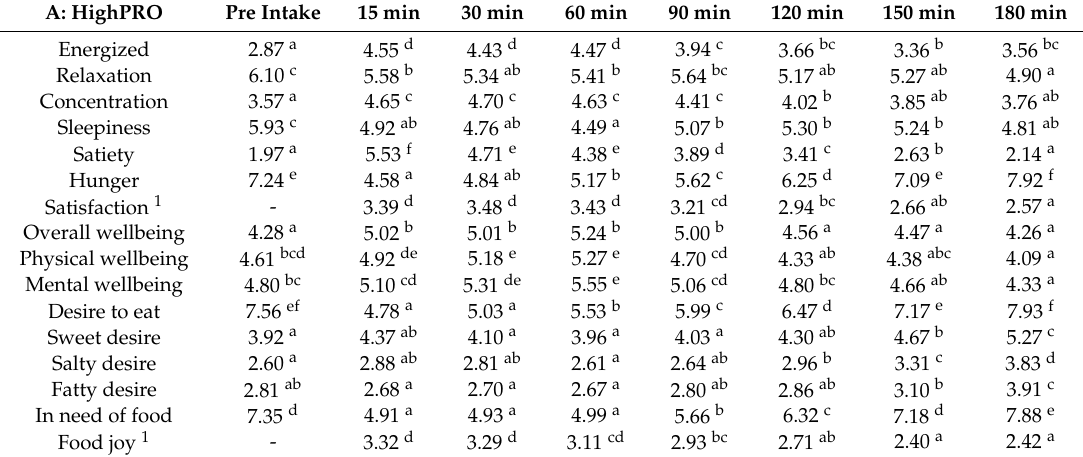
Table 5. Time e ff ects and means values ( n = 48) of post-ingestive sensations for HighPRO (A) at di ff erent time points after